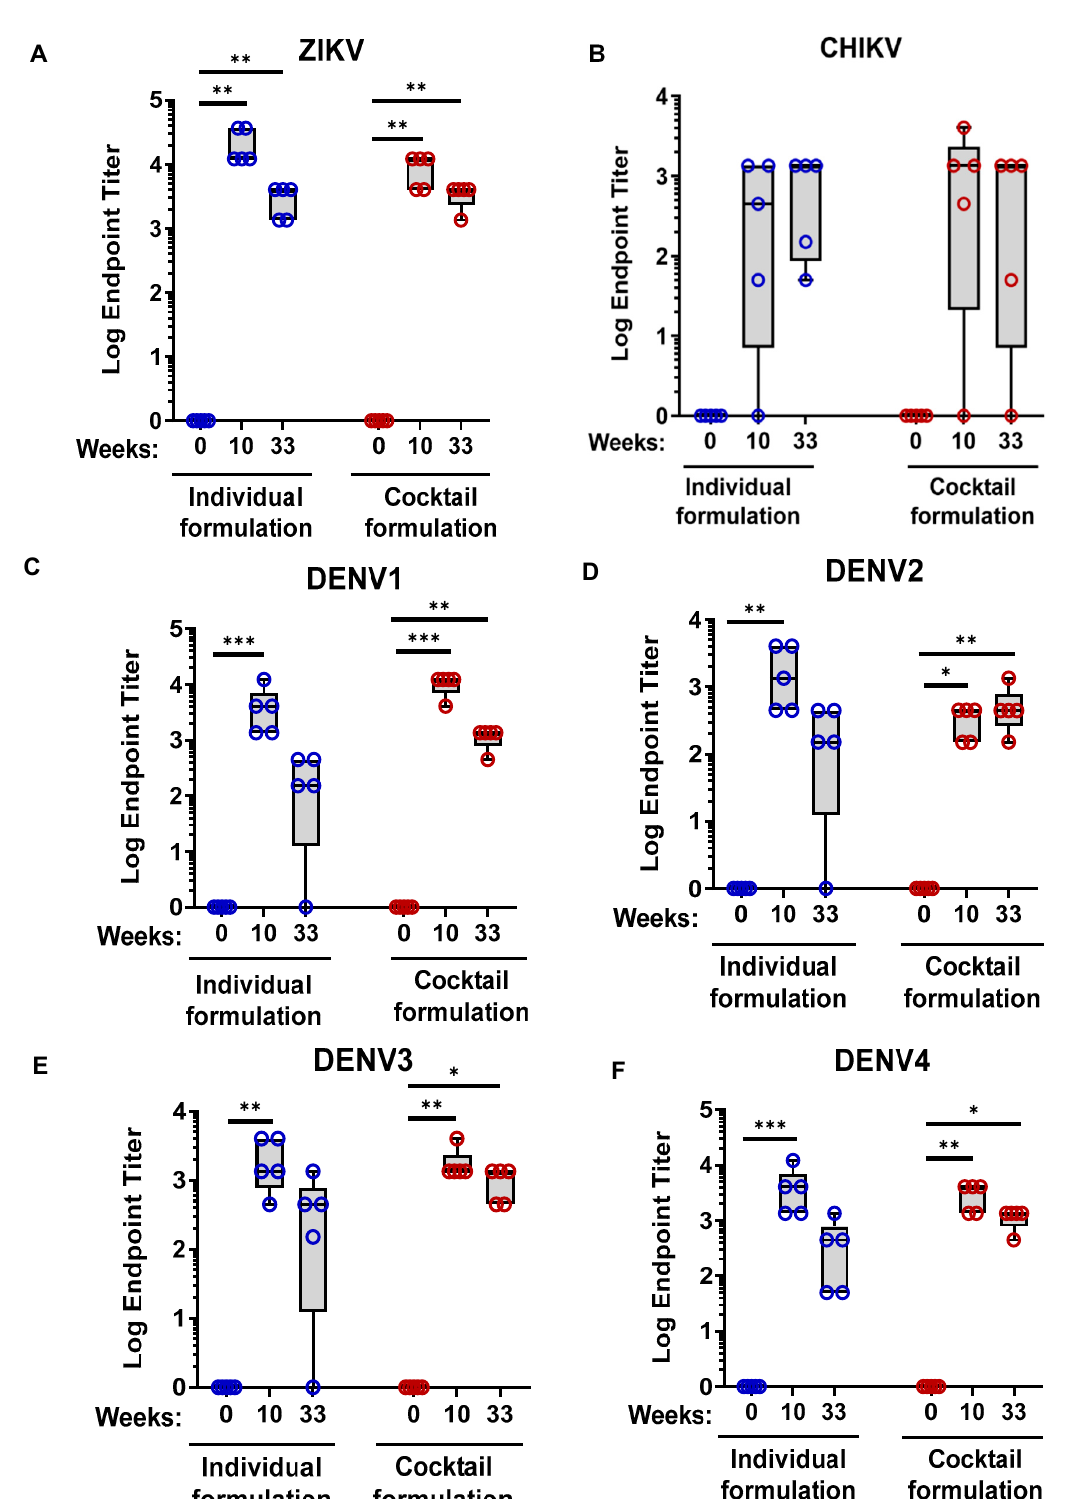
Figure 6. Durability of MMBV DNA vaccine induced humoral immune responses in NHPs. Rhesus macaques were immunized as described in Figure 4. Serum IgG EPTs for individual NHPs were measured at six months (week 33) post final immunization by binding ELISA to ZIKV ( A ), CHIKV ( B ), DENV1 ( C ), DENV2 ( D ), DENV3 ( E ), and DENV4 ( F ) envelope proteins. Data represents binding IgG endpoint titers of individual NHPs. The * p < 0.05, ** p < 0.01, *** p < 0.005. There were no significant differences between individual and cocktail formulation treatment groups.